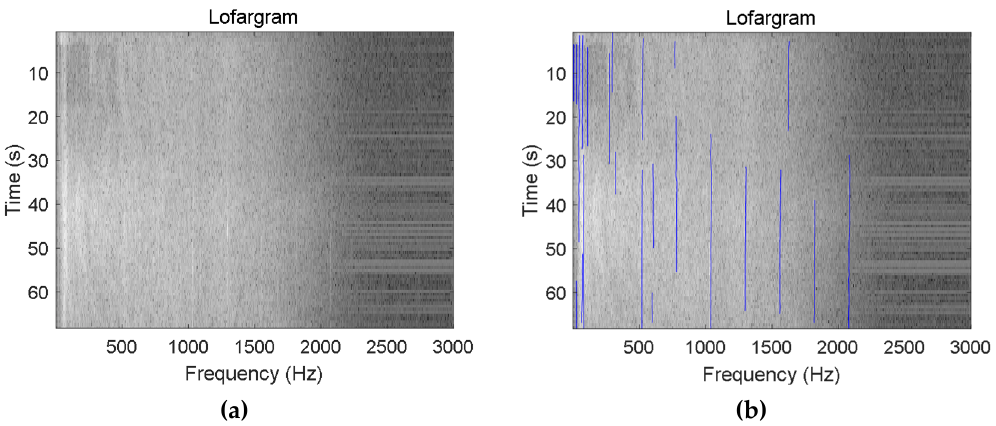
Figure 20. Frequency line tracking results of sea trial data: ( a ) Initial lofargram; ( b ) Tracking